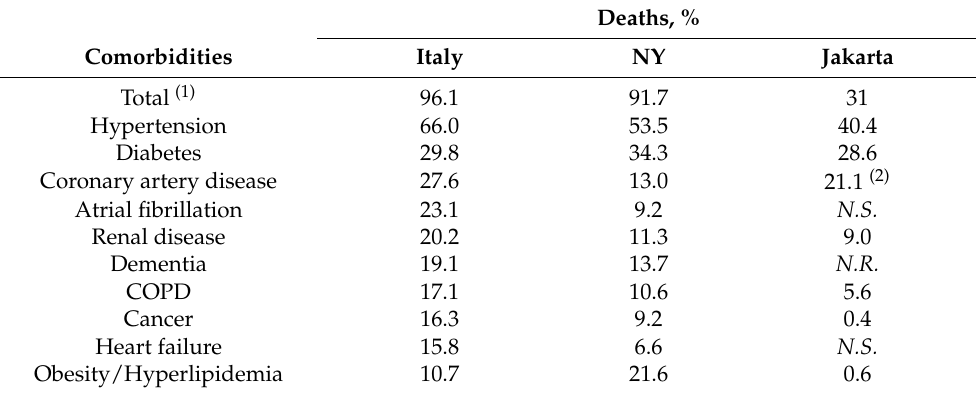
Table 1. Deaths in confirmed COVID-19 patients in relation to pre-existing comorbidities.